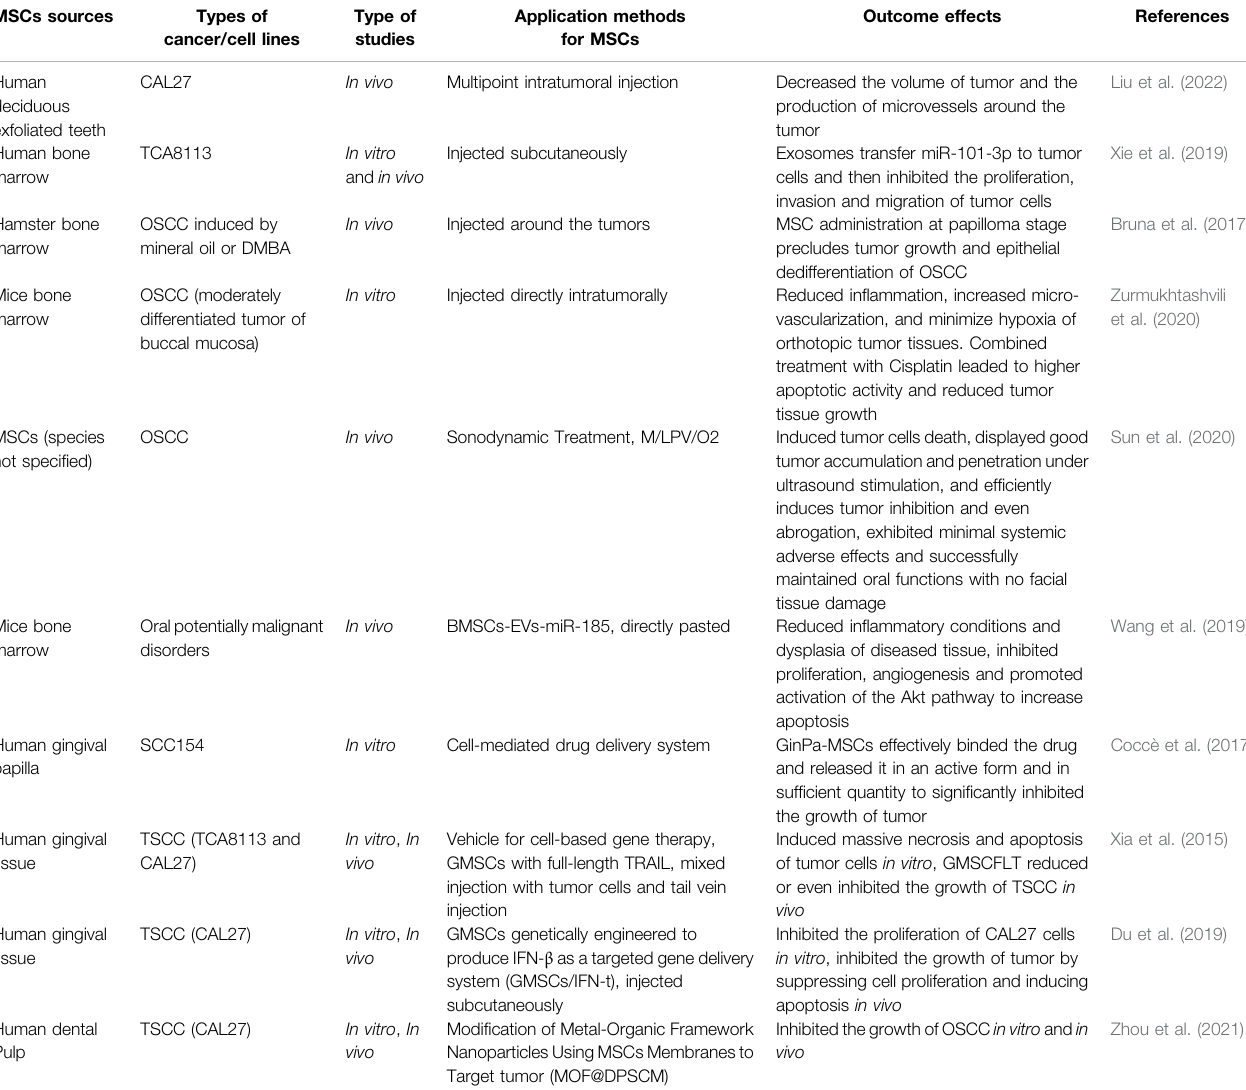
TABLE 2 | MSCs-mediated treatment of oral